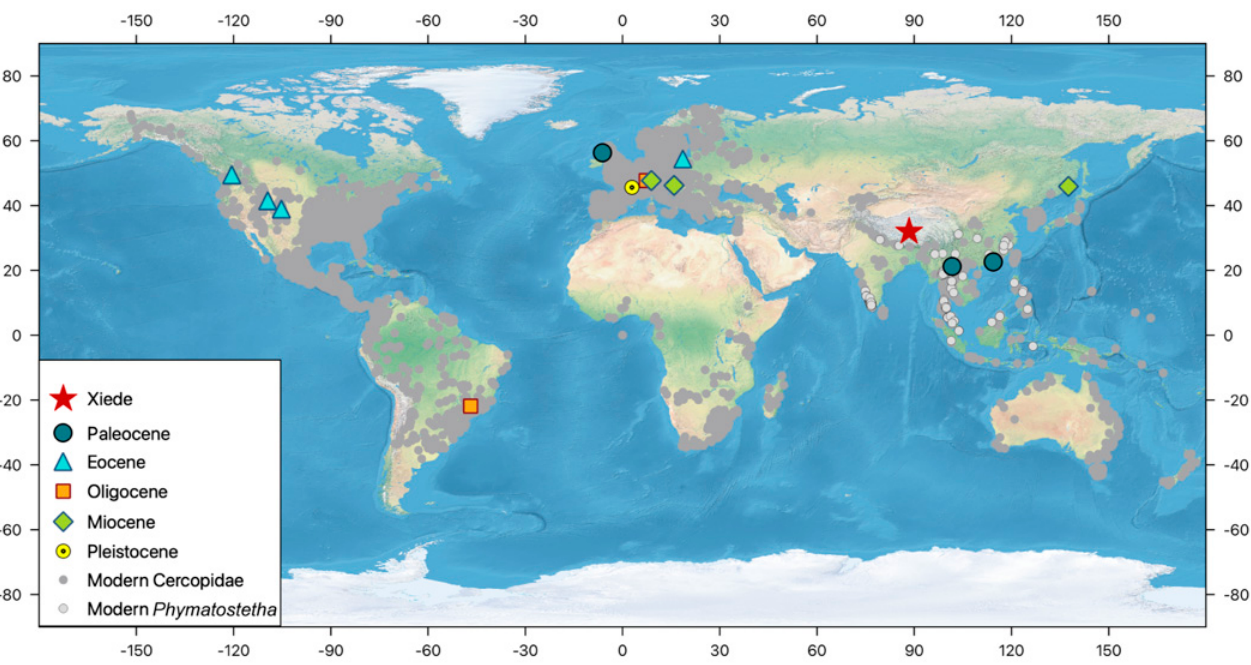
Figure 7. Localities of fossil taxa ascribed to Cercopidae and the modern relatives (note that the taxonomic placement of the fossil record presented here is in need of revision). Localities of fossil sites according to Fossilworks.org [9] and PaleoBioDB.org [10]; modern distribution of Phymatostetha and Cercopidae according to GBIF.org (doi: https://doi.org/10.15468/dl.desftn;